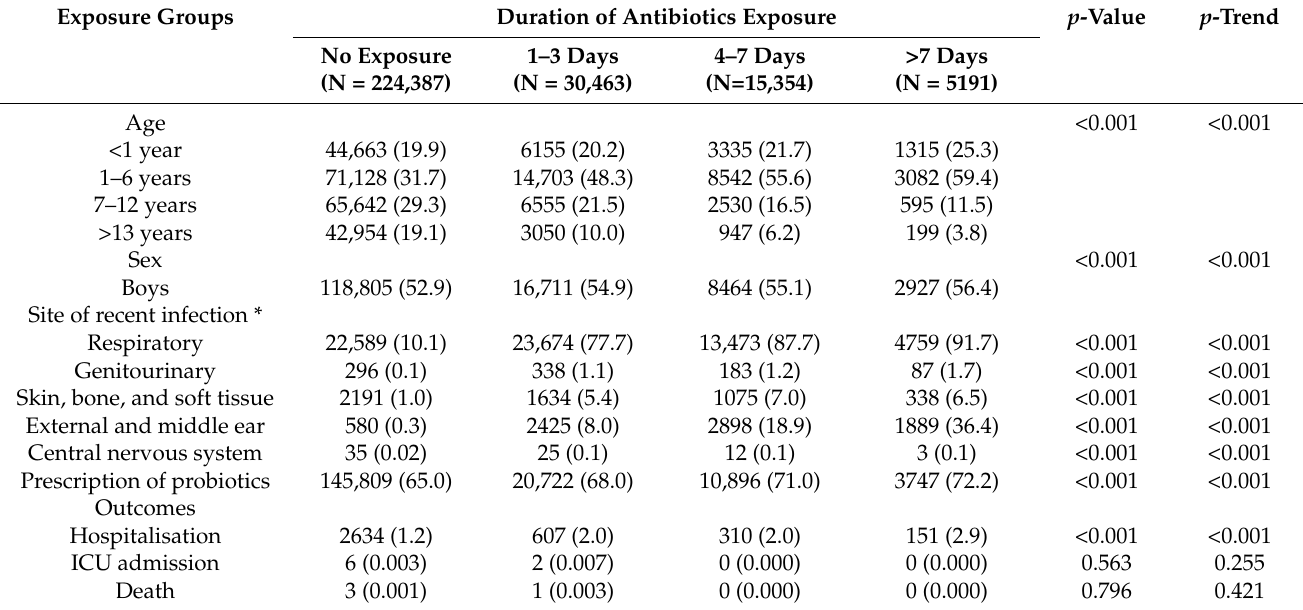
Table 1. Baseline characteristics and outcome